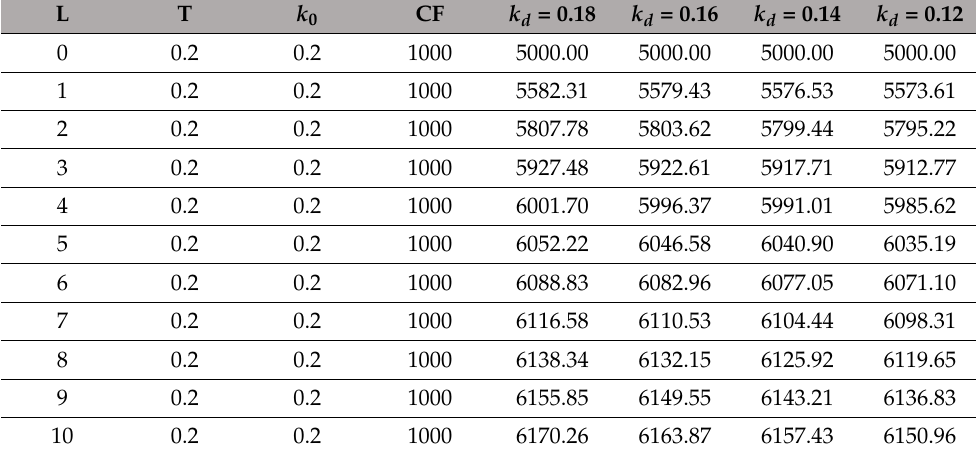
Table A6. Dependence of the company capitalization, V , on leverage level L at p = 2 and different